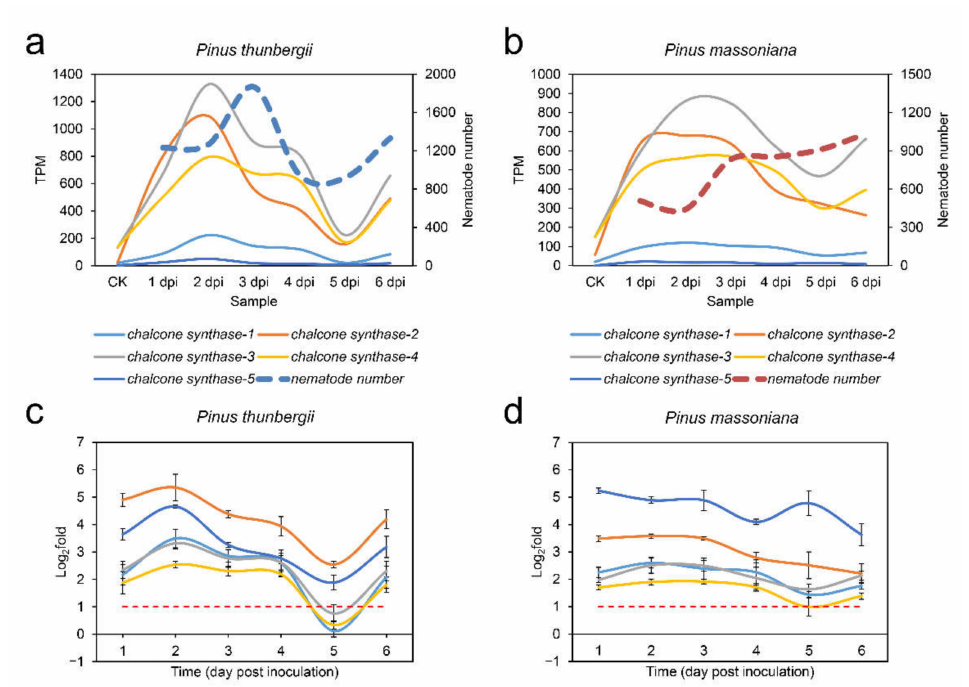
Figure 6. Expression patterns of chalcone synthase genes at different time points. ( a ) Expression levels for chalcone synthase genes based on per kilobase of exon model per million mapped reads (TPM) in Pinus thunbergii ; ( b ) expression levels for chalcone synthase genes based on TPM in P. massoniana ; ( c ) changes in expression levels verified by real-time quantitative PCR (RT-qPCR) for chalcone synthase genes in P. thunbergii ; ( d ) changes in expression levels verified by RT-qPCR for chalcone synthase genes in P. massoniana . The data are given as the mean or mean with standard